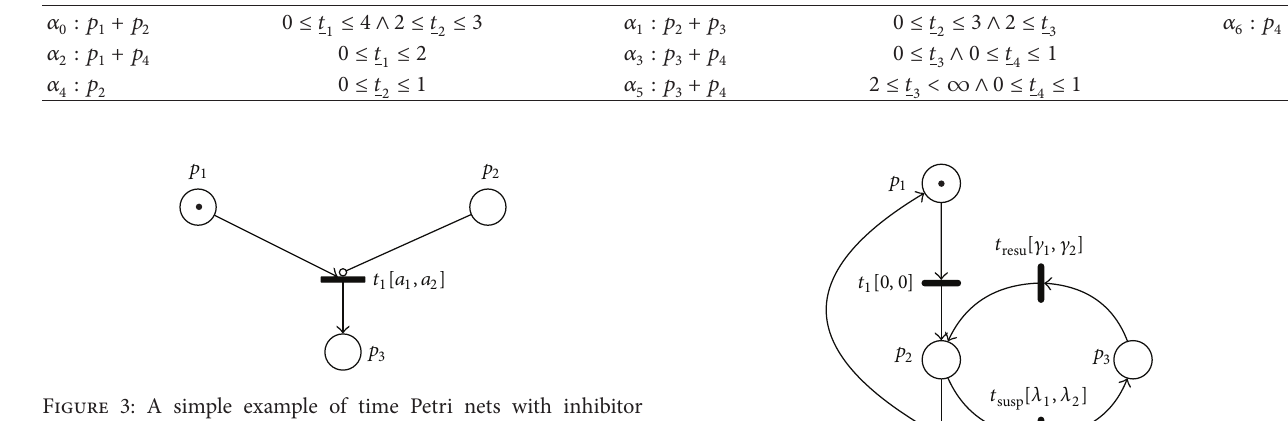
Table 1: The state classes of the TPN presented at Figure 2.